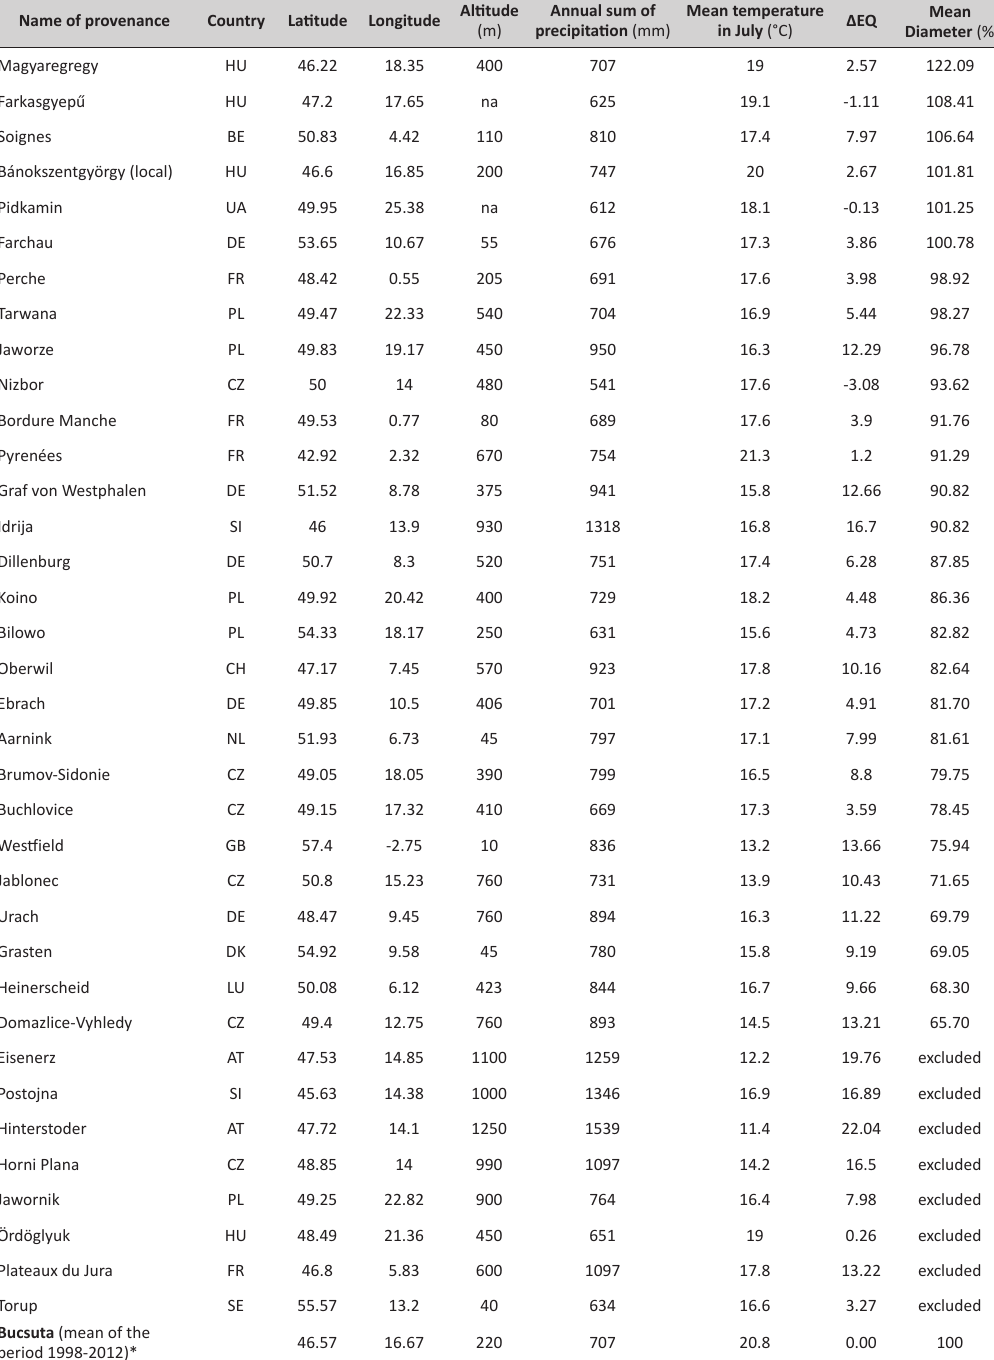
TaBle 1. Geographic data, the annual sum of precipitation and July mean temperature (for the period 1950-2000) of provenances, as well as their ecodistance, expressed in Ellenberg drought index (∆EQ), ranked by 15-year diameter data in Bucsuta (in % of the “theoretical local” performance*; see explanation in the